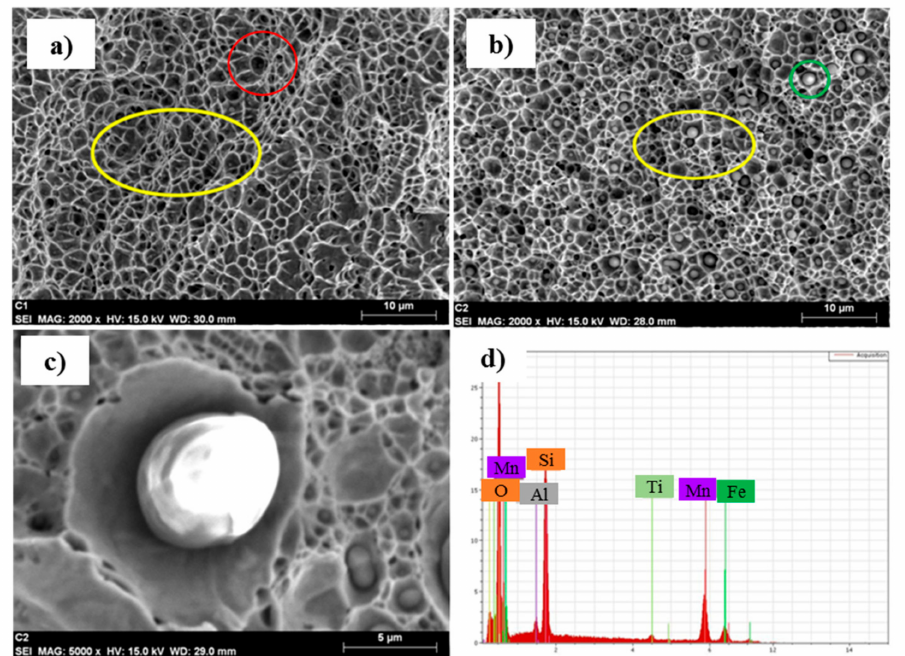
Figure 12. Fracture of the GMA welds with the ER 80S electrode: ( a ) low heat input, ( b ) high heat input, ( c ) analyzed particle and ( d ) EDS spectrum.